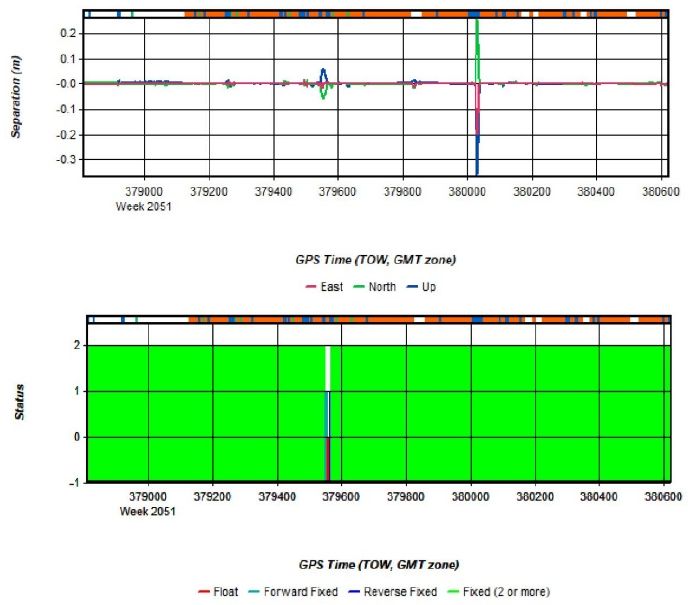
Figure 10. Combined separation and number of satellites for Sânmihaiu Român.